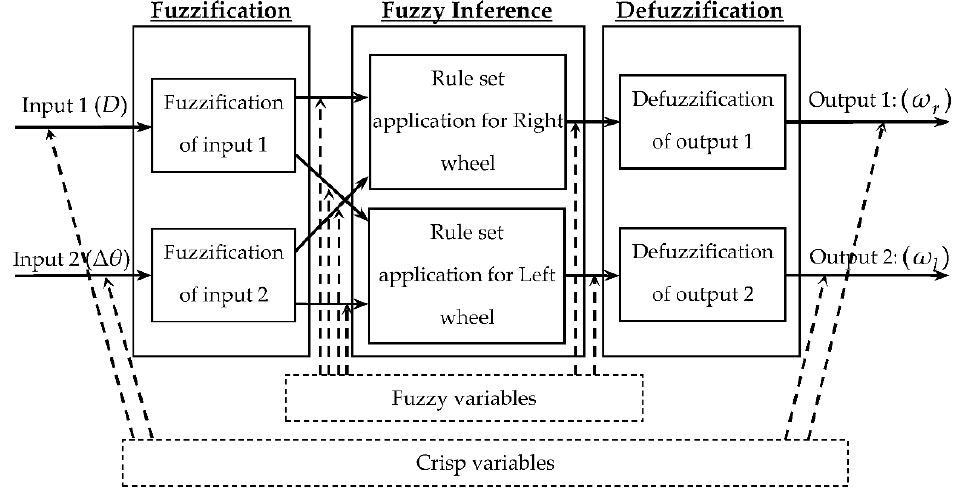
Figure 7. The fuzzy logic controller used for the differential drive robot.